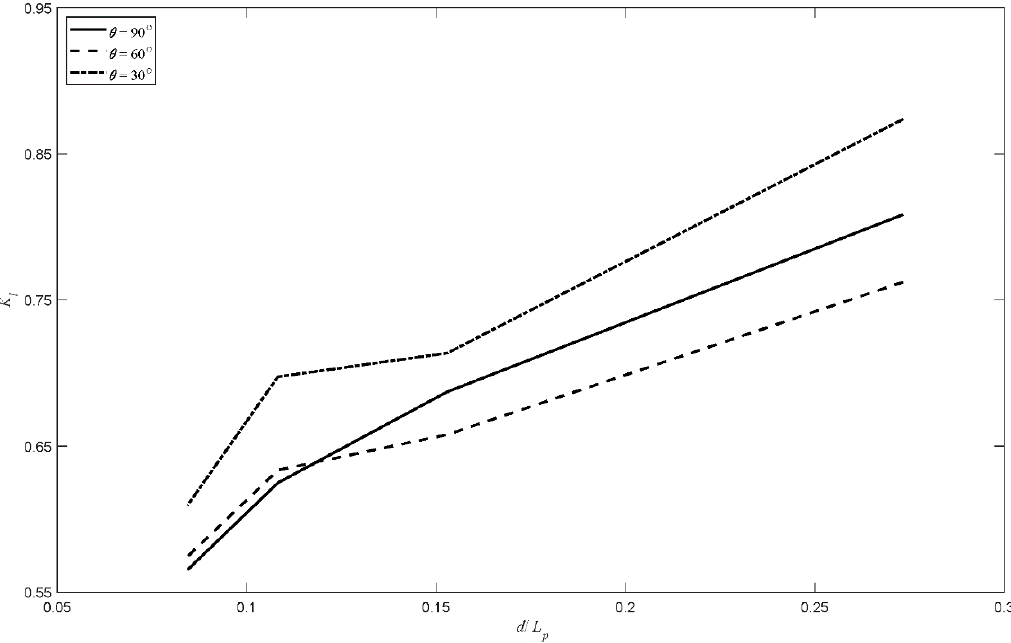
Figure 24. Example of the Effect of θ on the variation of 𝐾 (cid:3039) for P = 20, 𝑁 = 2, and 𝐻 (cid:3036)(cid:3046) / 𝑑 = 0.